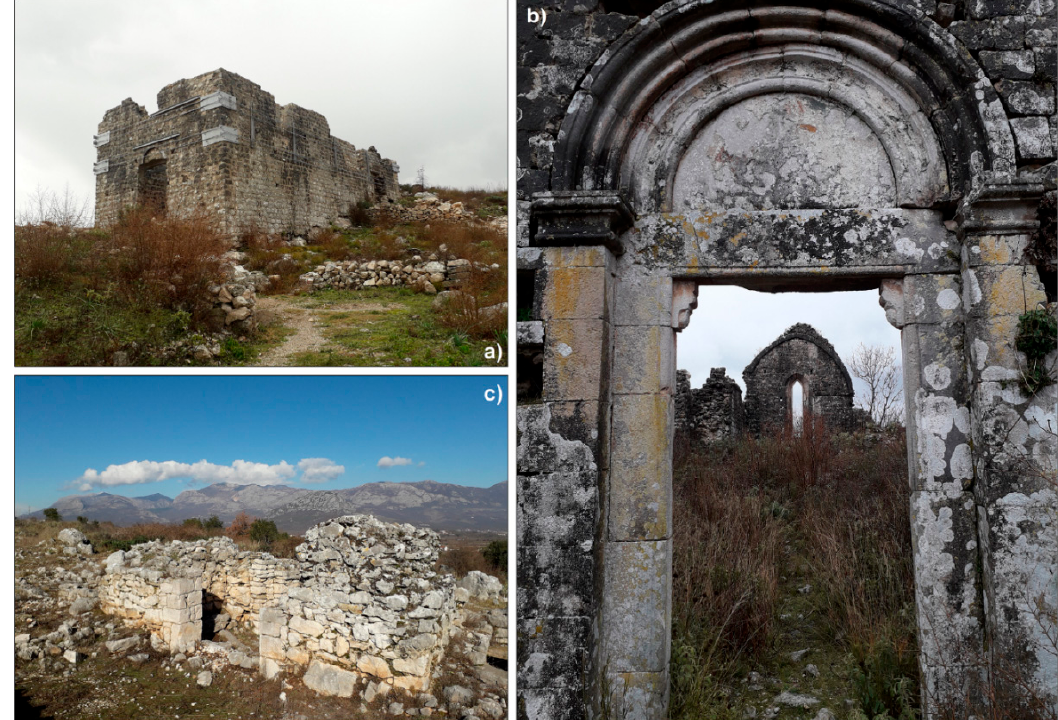
Figure 17. Sva č : St John Church ( a ), Holy Mary Church ( b ) and a gate with maybe a church at a top ( c ) respectively signed in Figure 16 with numbers 1–3.